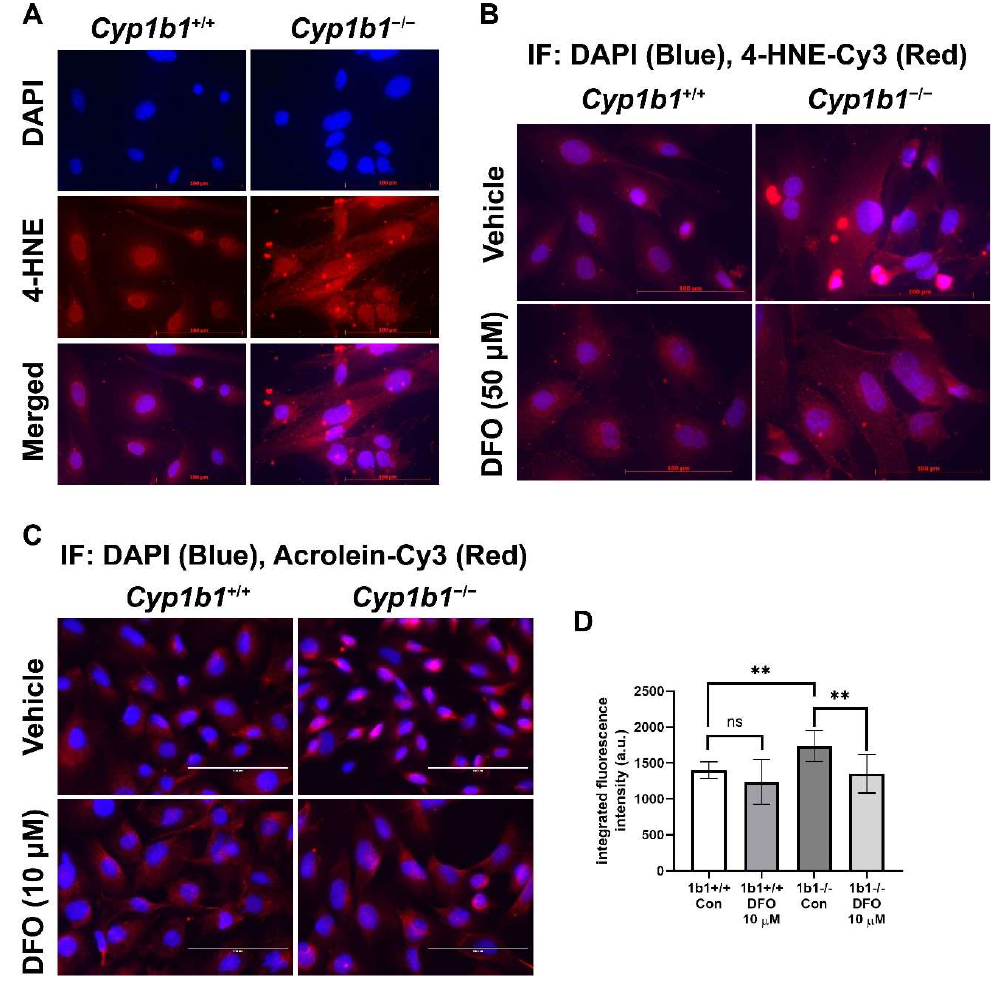
Figure 6. Upregulation of lipid peroxidation in Cyp1b1 −/− retinal ECs. ( A ) Cyp1b1 +/+ and Cyp1b1 −/− retinal ECs were stained with anti-4-hydroxynonenal (4-HNE, red) antibody and DAPI (blue) to determine cellular 4-HNE levels (scale bars = 100 µm). ( B ) Cyp1b1 +/+ and Cyp1b1 −/− retinal ECs were incubated with 50 µM DFO for 24 h and stained with anti-4-HNE antibody and DAPI. ( C ) Cyp1b1 +/+ and Cyp1b1 −/− retinal ECs were incubated with 10 µM DFO for 48 h and stained with anti-acrolein antibody (red) and DAPI (blue) scale bars = 100 µm. ( D ) Acrolein staining intensities were measured using ImageJ for quantitative analysis (** p < 0.01; n = 10 for each group; ns: not significant). 2.6. Increased Ferroptosis Sensitivity in Cyp1b1 −/− Retinal ECs Is Associated with ERα Activity The increased cellular iron level and lipid peroxidation in Cyp1b1 −/− retinal ECs sug- gest an enhanced rate of ferroptosis in these cells. Ferroptosis is a form of iron-dependent cell death characterized by excessive accumulation of lipid peroxides and ROS [42]. To compare ferroptosis sensitivity of Cyp1b1 +/+ and Cyp1b1 −/− retinal ECs, we incubated the cells with different concentrations (0.05–10 µM) of erastin for 24 h. Erastin induces ferrop- tosis through suppression of cysteine uptake via system X c− [43]. Cell viability in response to erastin was analyzed via MTS assay and the results showed that erastin decreased cell viability in a dose-dependent manner. However, Cyp1b1 − / − retinal ECs were more sensitive to Erastin (0.5 µ M) incubation. Erastin reduced the viability of Cyp1b1 − / − retinal ECs by 67.4%, while that of Cyp1b1 +/+ retinal ECs was decreased by 11.2% (Figure 7A,B). Thus, Cyp1b1 − / − retinal ECs were more susceptible to erastin-mediated ferroptosis compared with Cyp1b1 +/+ retinal